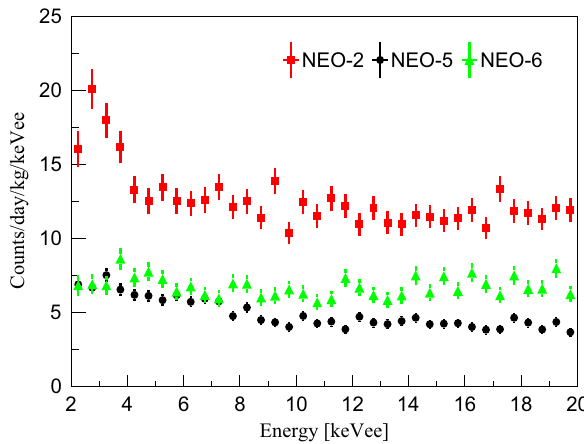
Fig. 16 Single-hit energy spectrum comparisons for three different- sizedcrystals(4-inchlongNEO-6and8-inchlongNEO-5)anddifferent contamination levels (NEO-2) are shown for an energy region of 2– 20keVee. Owing to a particularly large contamination of 210 Pb and 40 K, the NEO-2 crystal has approximately twice the background level. Although the 4-inch-long crystal has a higher background level above the 8keVee energy region owing to the larger impact of the external radiation, the low-energy spectrum around 2–6keVee region is similar with the 8-inch-long crystal when the internal contamination levels are similar